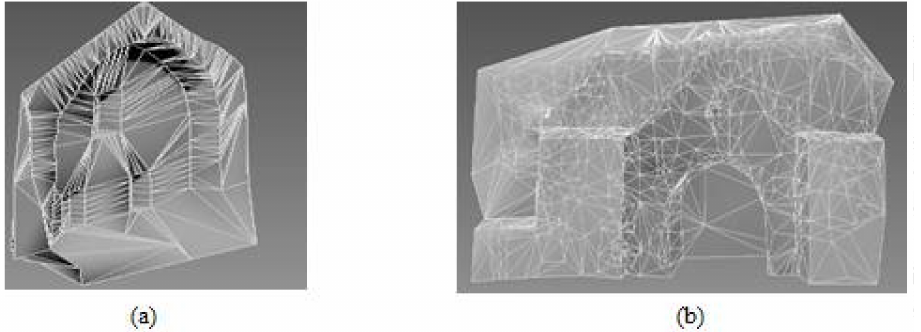
Figure 7. The 3D model reconstruction for the Neoria building using the georeferenced data points: ( a ) front façade; and ( b ) right